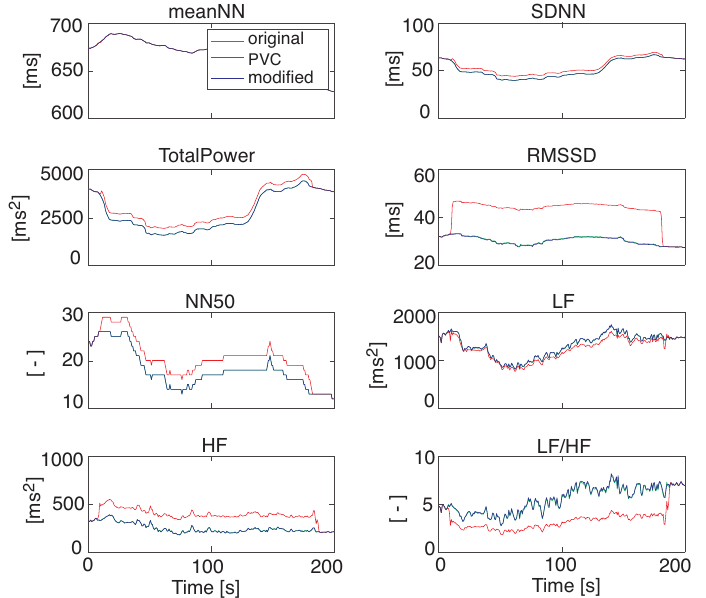
Figure 7. The RRI modification result of PVC ( top ) and its enlarged display ( bottom ). The blue, red, and green lines represent the original RRI data, the RRI data with artificial PVC data, and the RRI data modified by the proposed DAEM, respectively. The modified data (the blue line) overlapped almost entirely with the original data (the green line) due to the high modification performance.